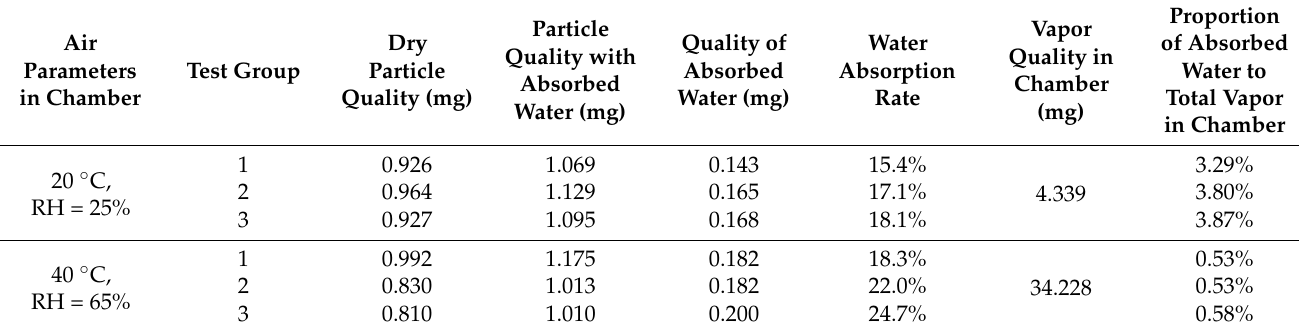
Table 2. Water absorption rates of biomass particles.